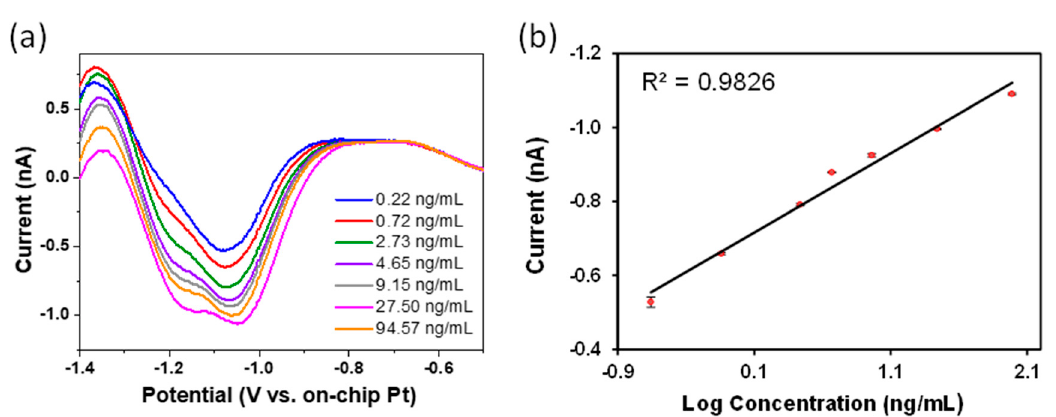
Figure 4. ( a ) Square wave voltammogram of Clothianidin recorded at different concentrations in acetate buffer (pH 5) versus on-chip Pt pseudo reference electrode. ( b ) Calibration plot of peak current vs. log concentration of clothianidin solution. Error bars are included in clear data points.